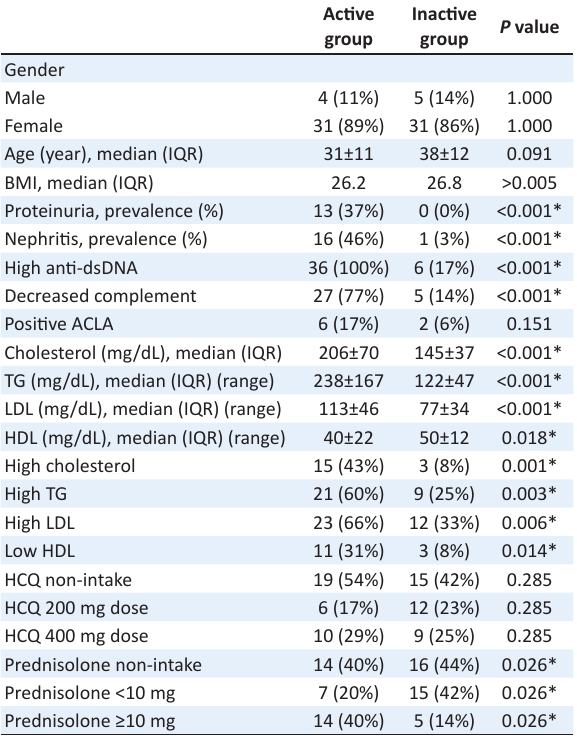
Table 1. Baseline characteristics, laboratory tests and drug consumption of the patients